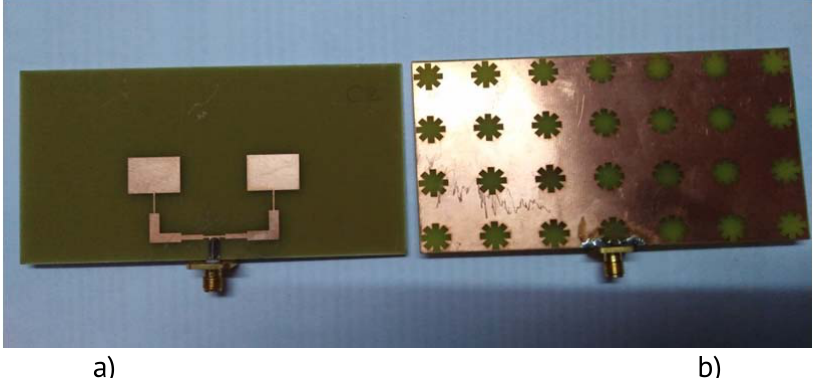
Figure 9. Photograph of microstrip antenna array with star slot EBG structure: a) front view; b) back view.